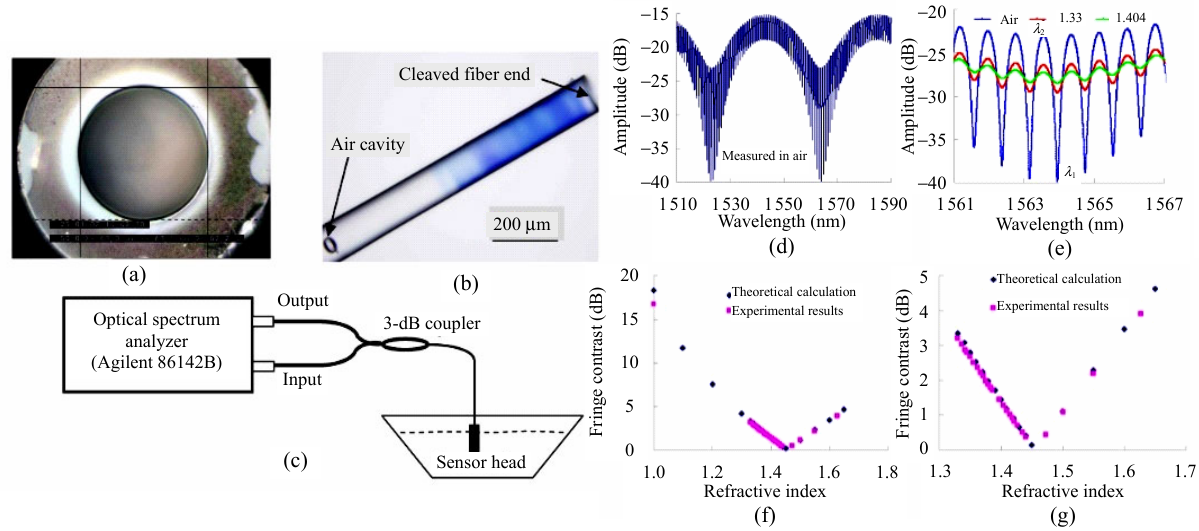
Fig. 20 Microscopic image and experimental setup of the FP sensor based on the micromachined hole introduced on the fiber cross section and its RI